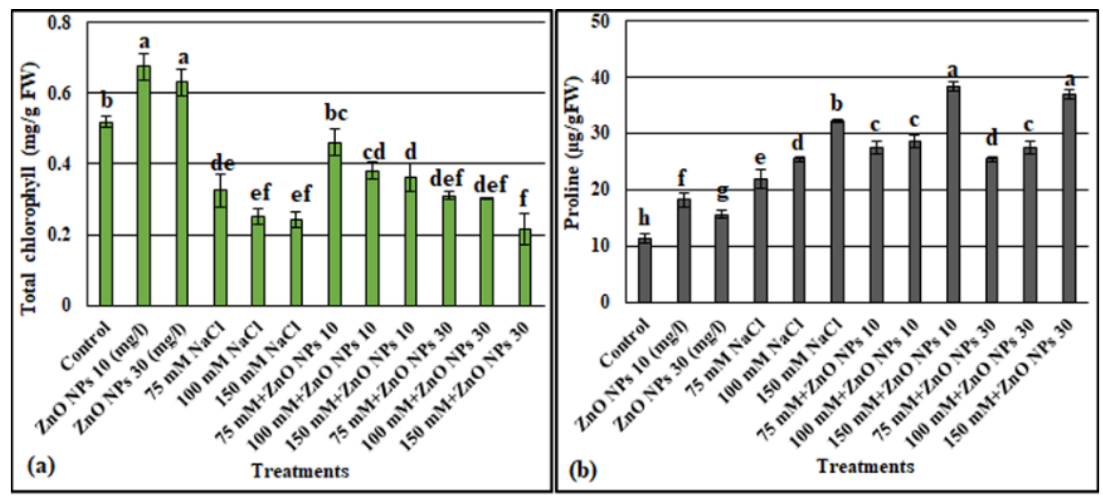
Figure 6. Effect ZnO NPs (10 mg/L and 30 mg/L) on total total chlorophyll content ( a ) and proline accumulation ( b ) in the shoot of Salvia officinalis cultivated 0, 75, 100, and 150 mM of NaCl. Each value is the mean of three replicates ± SD. The significant differences between the treatments are indicated by different letters on bars. The Duncan’s test analysis at p < 0.05 was used.